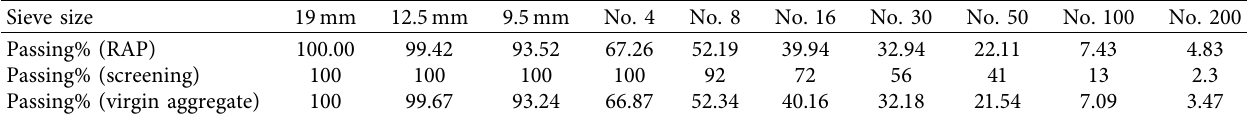
Table 1: Gradation of the RAP, screening, and virgin